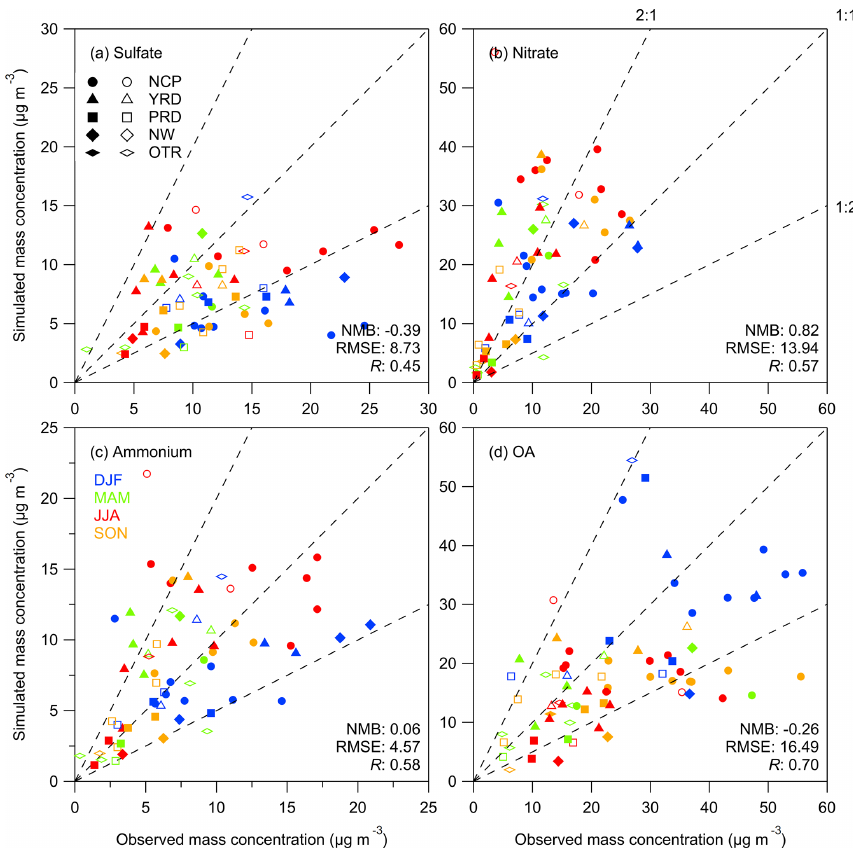
Figure 1. Scatterplots of the simulated and observed campaign-average mass concentrations of (a) sulfate, (b) nitrate, (c) ammonium, and (d) OA in China. The solid and open symbols represent the urban and non-urban sites, respectively. Colors and shapes of the symbols represent seasons and regions, respectively. The observations were conducted during 2006 to 2016 for submicron particles, and the data were divided by a submicron-to-fine ratio of 0.8. The model simulations were run for the year